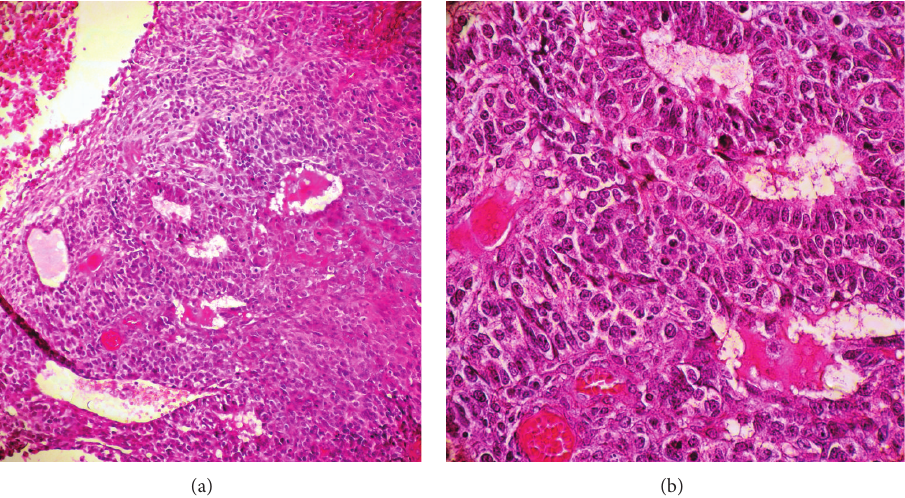
Figure 2: Histology of biopsy specimen revealing (a) diffuse sheets of neoplastic cells arranged in pseudorosettes and glandular formations (HES × 20), with (b) cytonuclear atypia and high mitotic index (HES ×